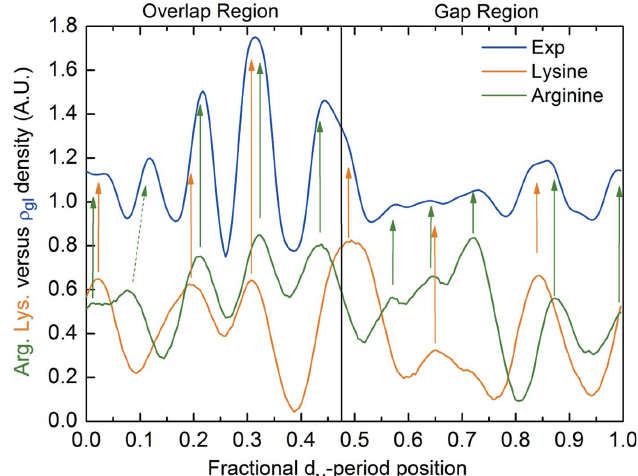
Figure 5 Linear densities of lysine/hydroxylysine and arginine amino acids as a function of the fractional d M -period coordinate along the collagen fibril versus the electron density obtained by the Fourier difference